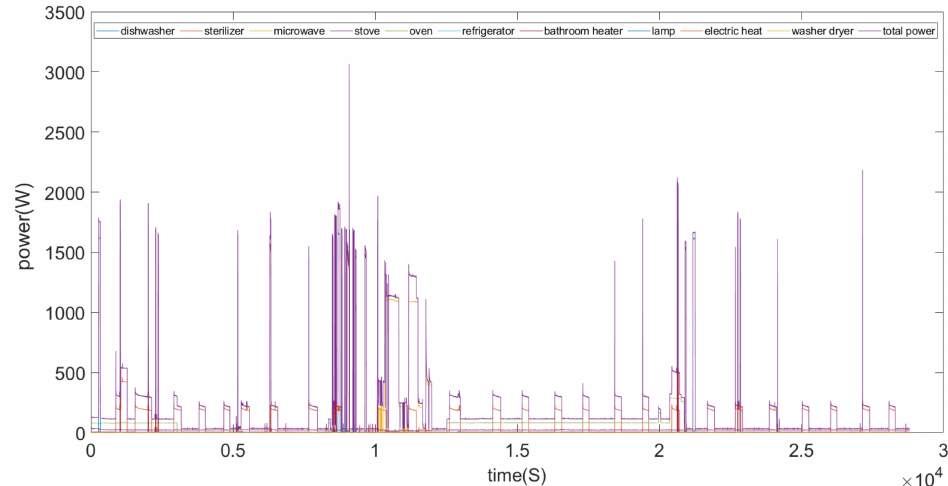
Figure 1. The power waveform of each load in a household in one day.